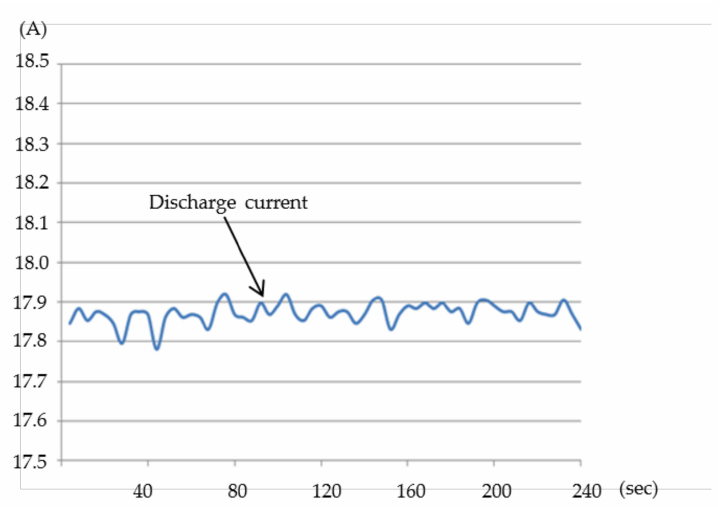
Figure 14. Discharge current value 18 A.